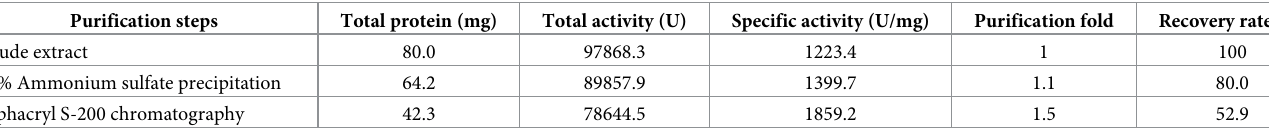
Table 1. Purification of recombinant